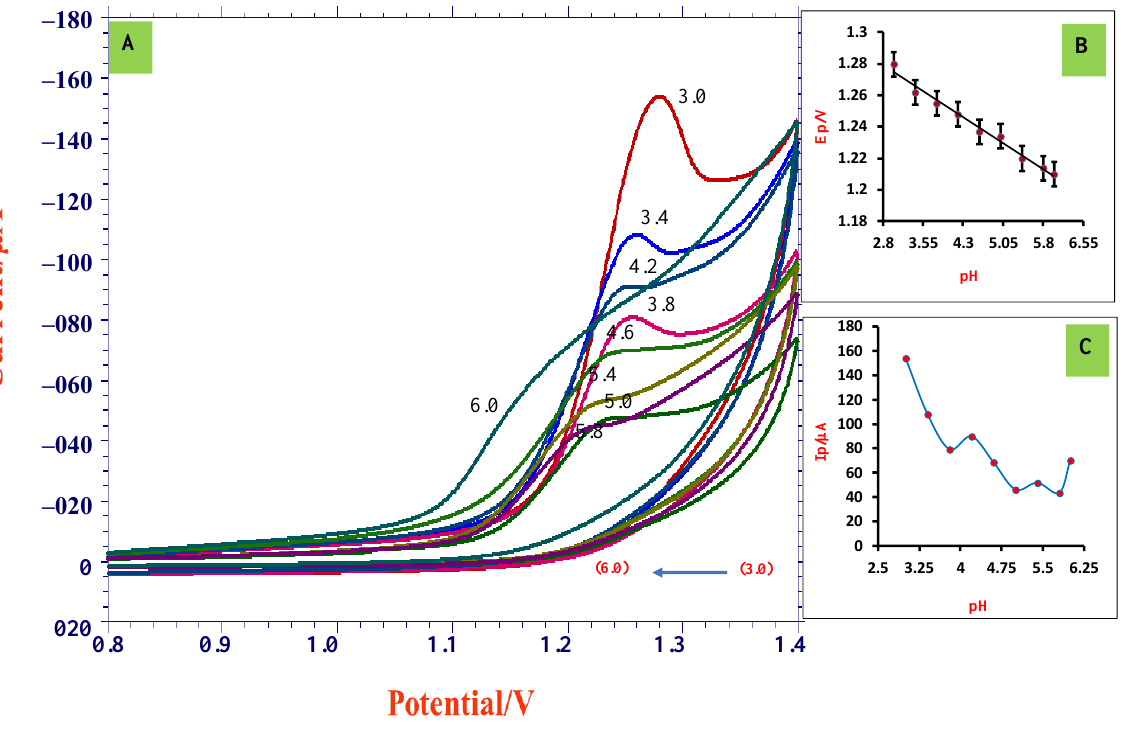
Figure 5. ( A ) CVs obtained for 0.5 mM TMP for various pH (pH 3.0–pH 6.0) employing ZnO/SDS/CPE at scan rate 0.05 V/s; ( B ) dependence of potential (Ep) on pH; ( C ) plot of peak current (Ip) vs. pH.